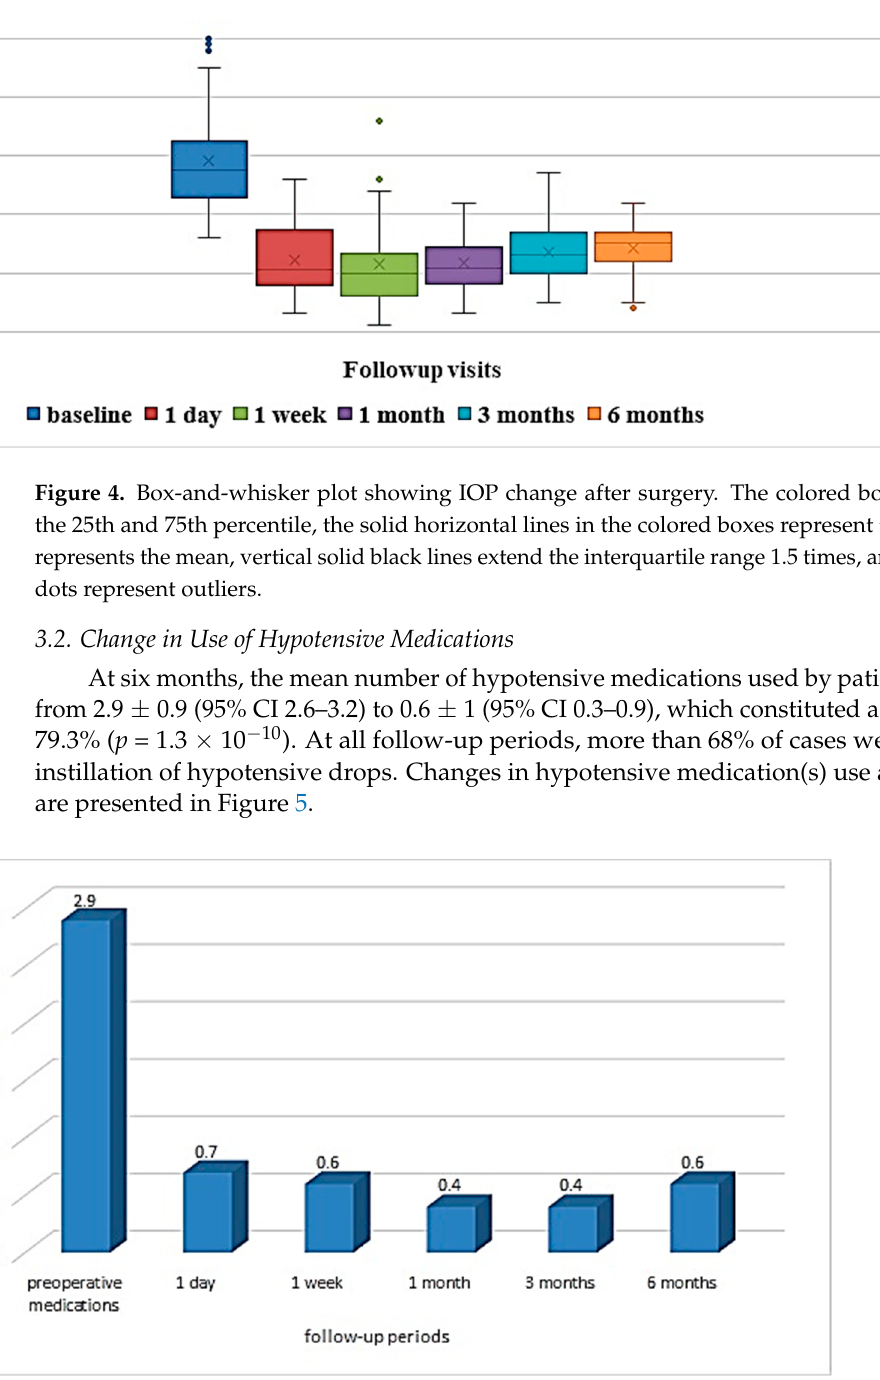
Figure 5. Bar diagram showing mean hypotensive medication use after surgery at different follow- up times. up